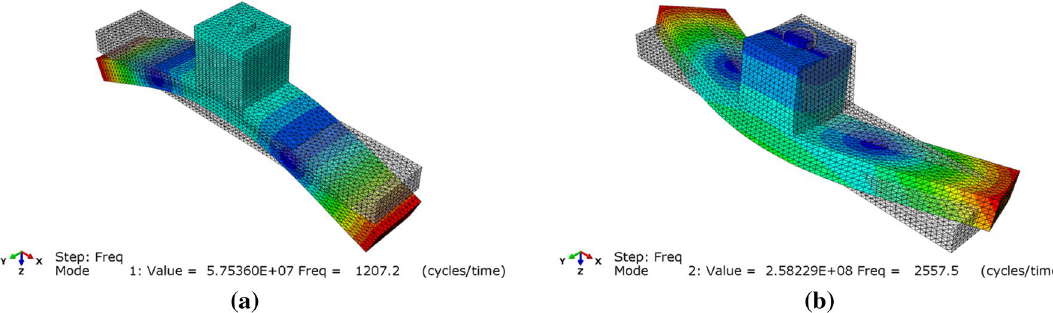
Fig. 2 Mode shape and natural frequency of the structure in the a first and b second mode of vibration